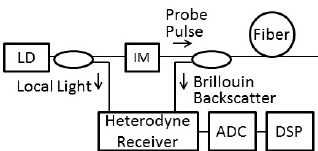
Figure 1. Basic configuration of Brillouin optical time-domain reflectometry (BOTDR). LD: laser diode; IM: intensity modulator; ADC: analog-to-digital convertor; DSP: digital signal processor.